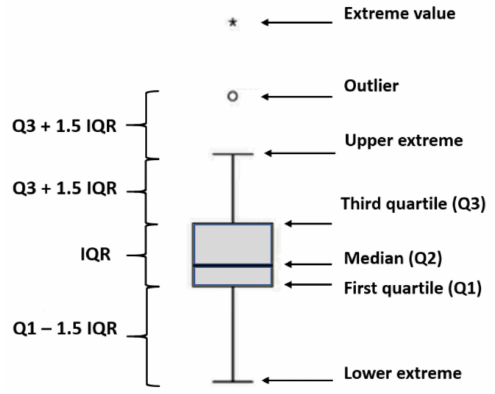
Figure 1. Scheme of the box-plot diagram.